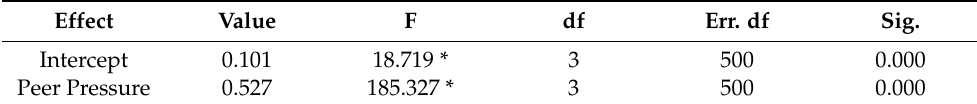
Table 2. Multivariate analysis.